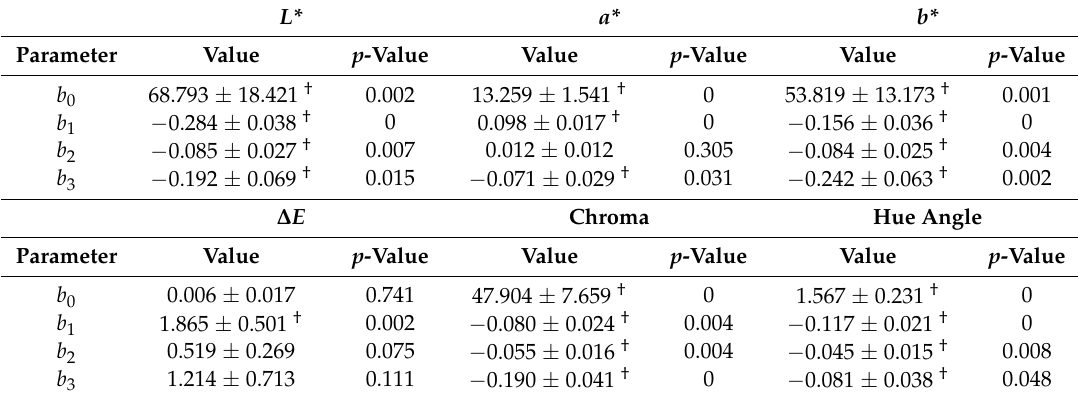
Table 3. Non-linear regression models coefficients for description of color component change during storage for tin can packaging (L1KMK) ( α = 95%) estimated using Statistica 10.0. † marked values are significant at p <